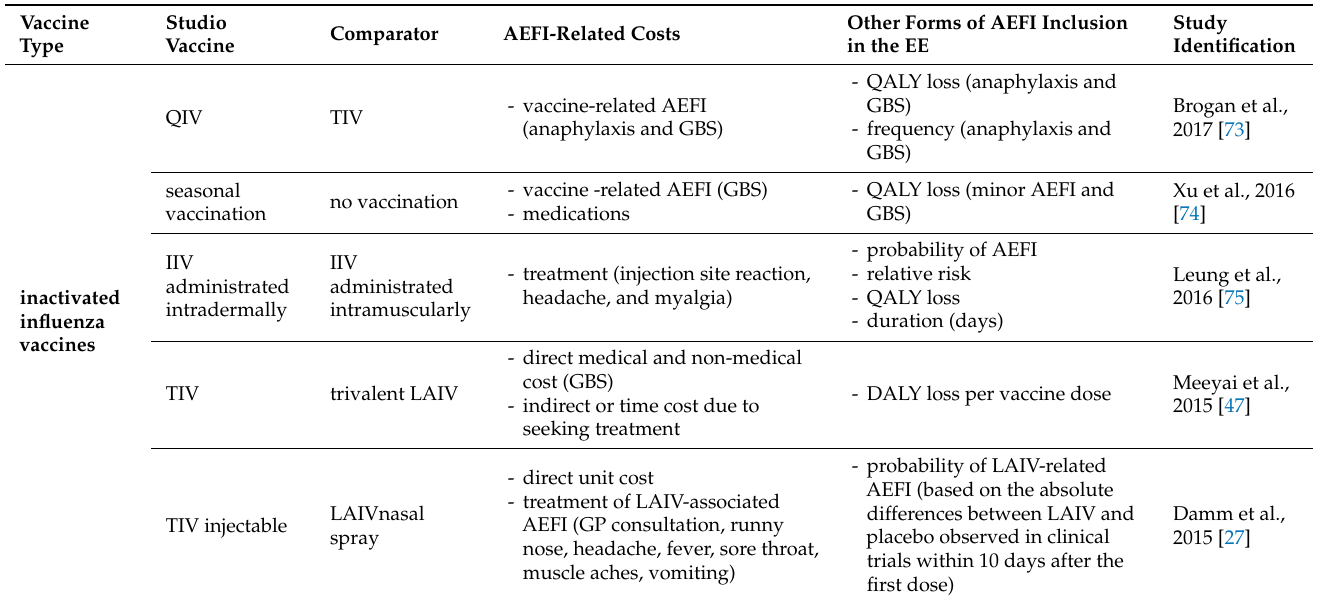
Table 3. Vaccine alternatives compared and AEFI outcomes reported within the 52